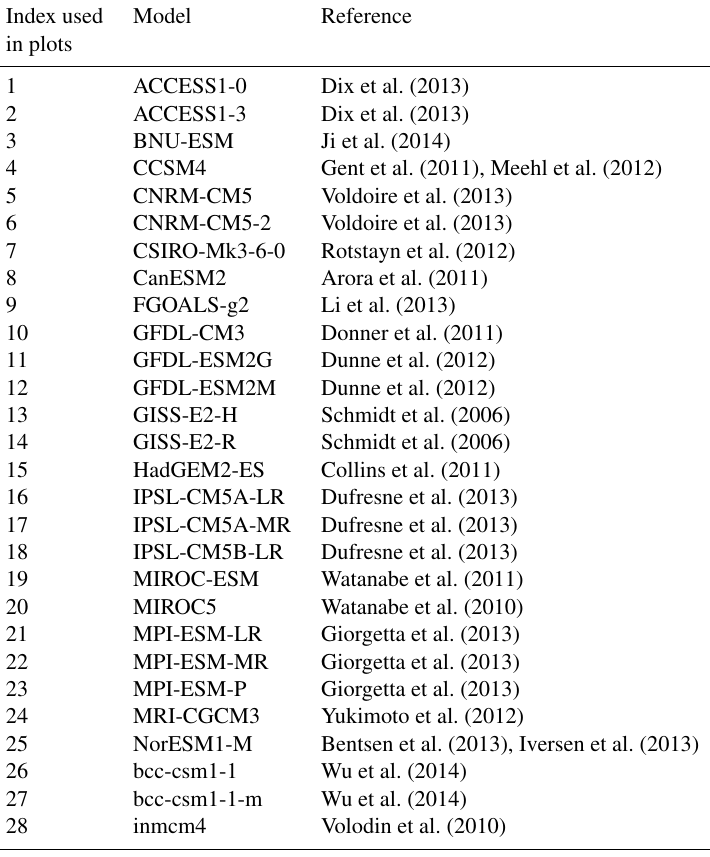
Table 2. List of CMIP5 models alongside the index used in the figures of this study and a reference. Index used Model Reference in plots